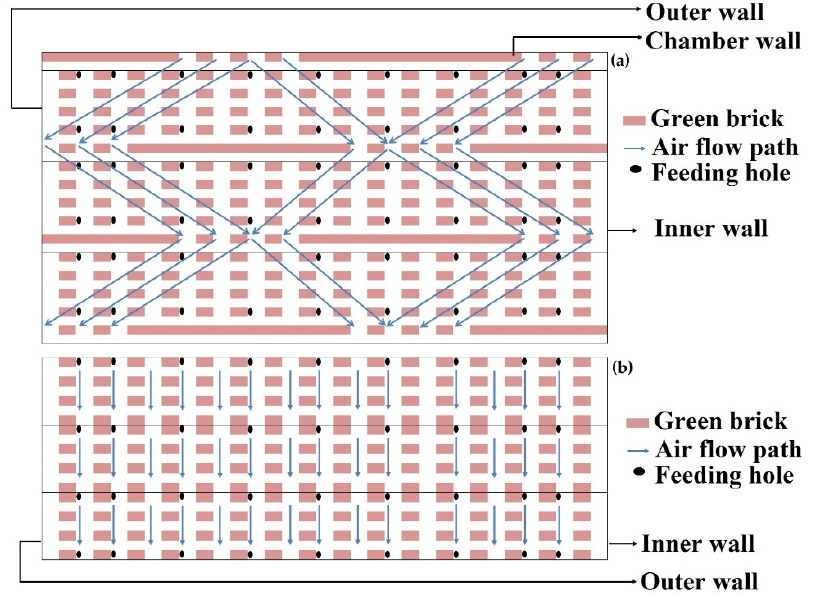
Figure 2. Illustration of stacking pattern of green bricks and air flow in ( a ) IDZKs and ( b ) FCBTKs; The pink color denote green bricks, blue arrows denote flow of air, and black circles denote feeding holes.